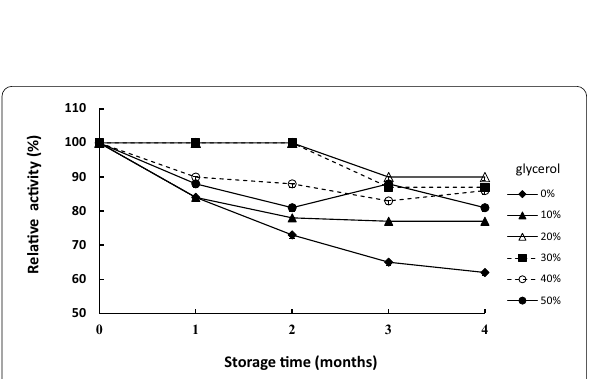
Fig. 9 The effect of glycerol on TvmNAG2 during the storage at 20 °C. TvmNAG2 containing 0–50% glycerol was stored at 1–4 months, followed by activity